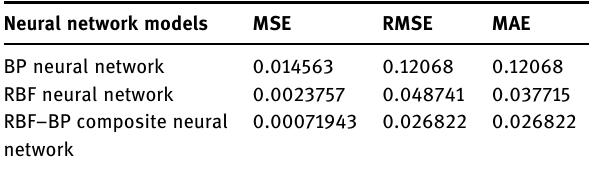
Table 6: Comparison of evaluation indices of each neural network